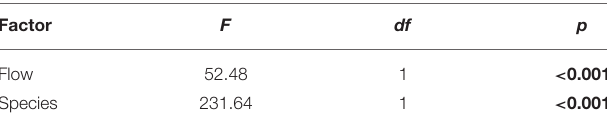
and acidified conditions, at all flow velocities except for 0.1